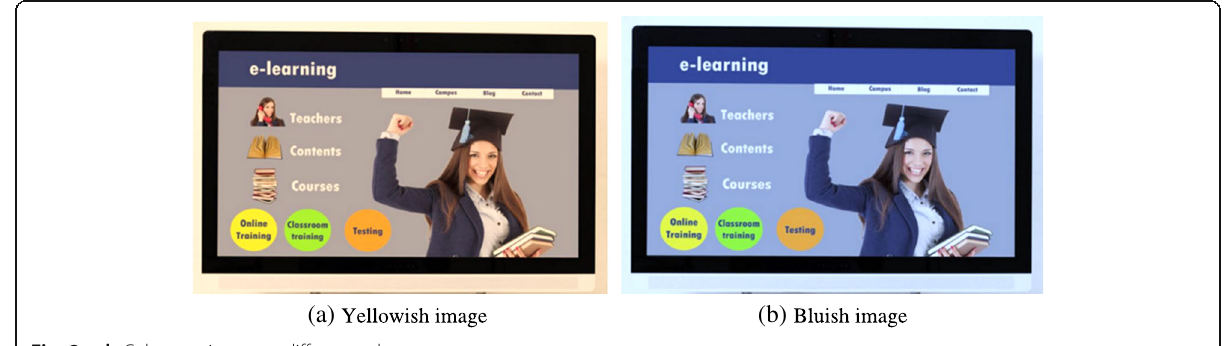
Fig. 2 a , b Color cast image at different color